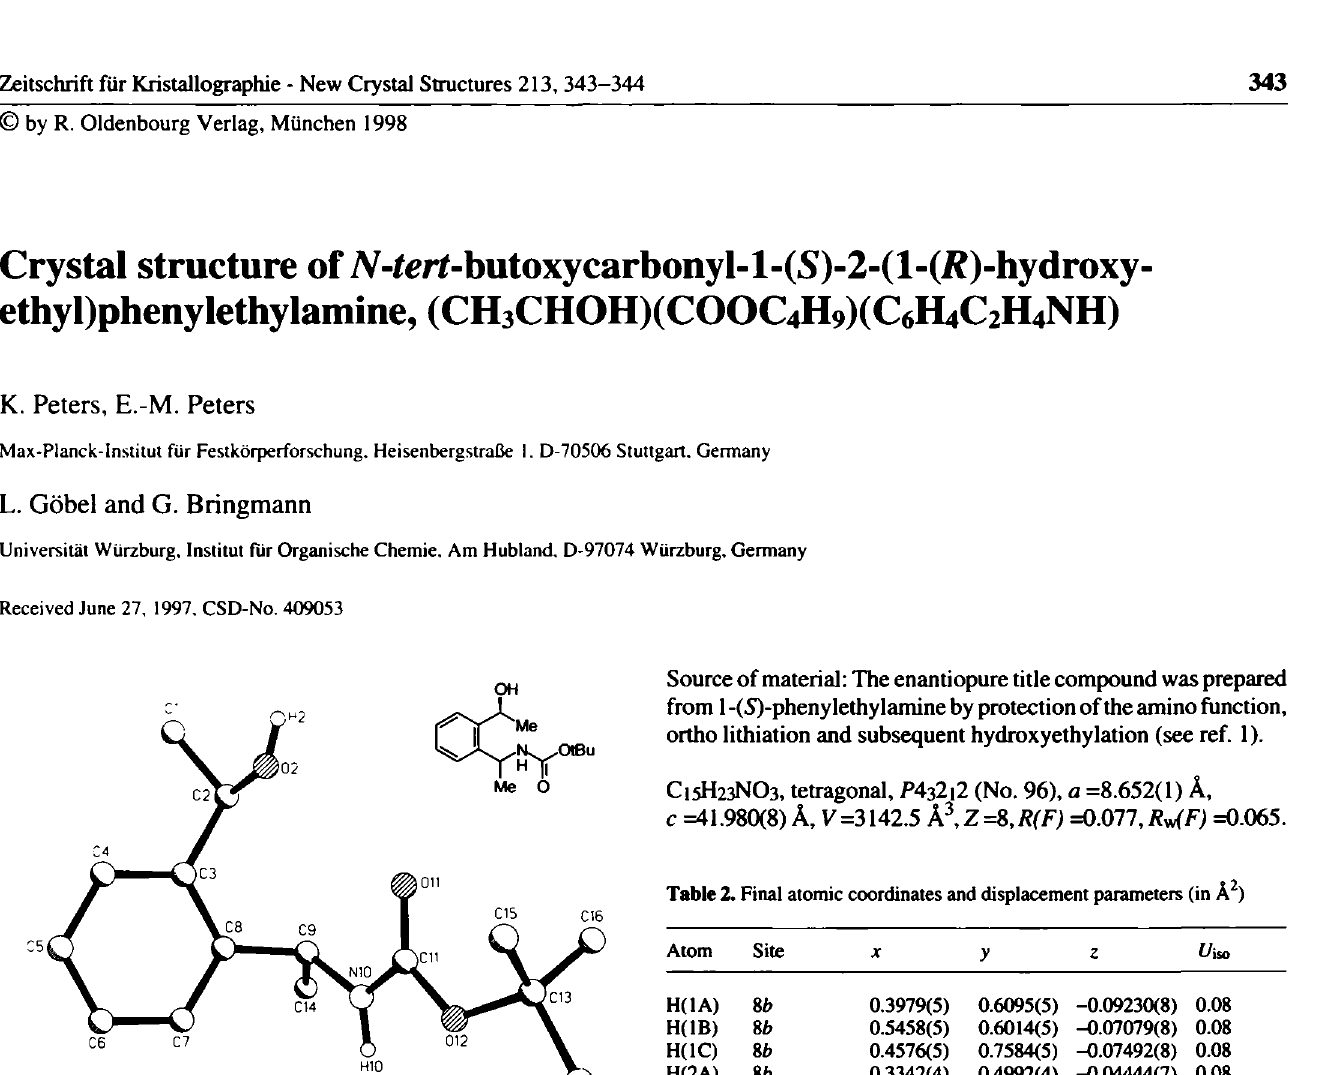
Table 1, Parameters used for the X-ray data collection